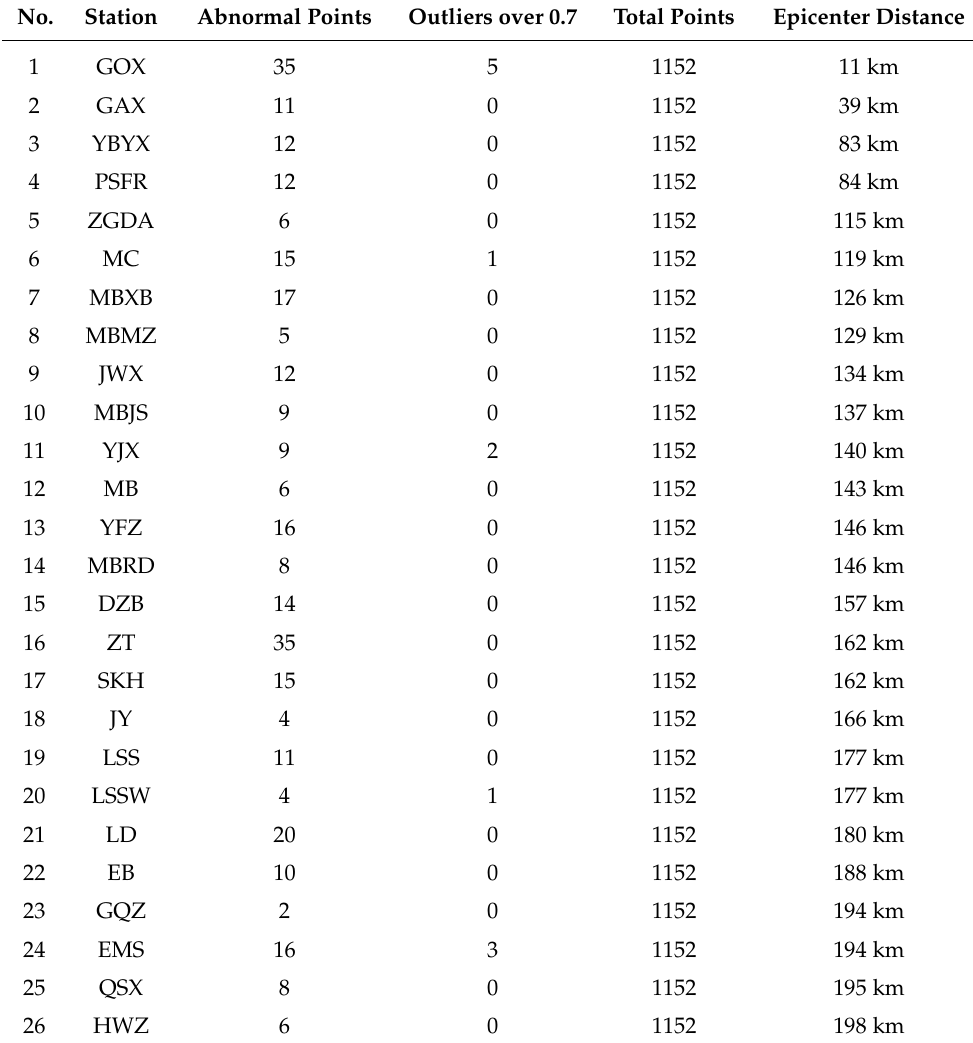
Table 4. Station abnormal points before the Yibin